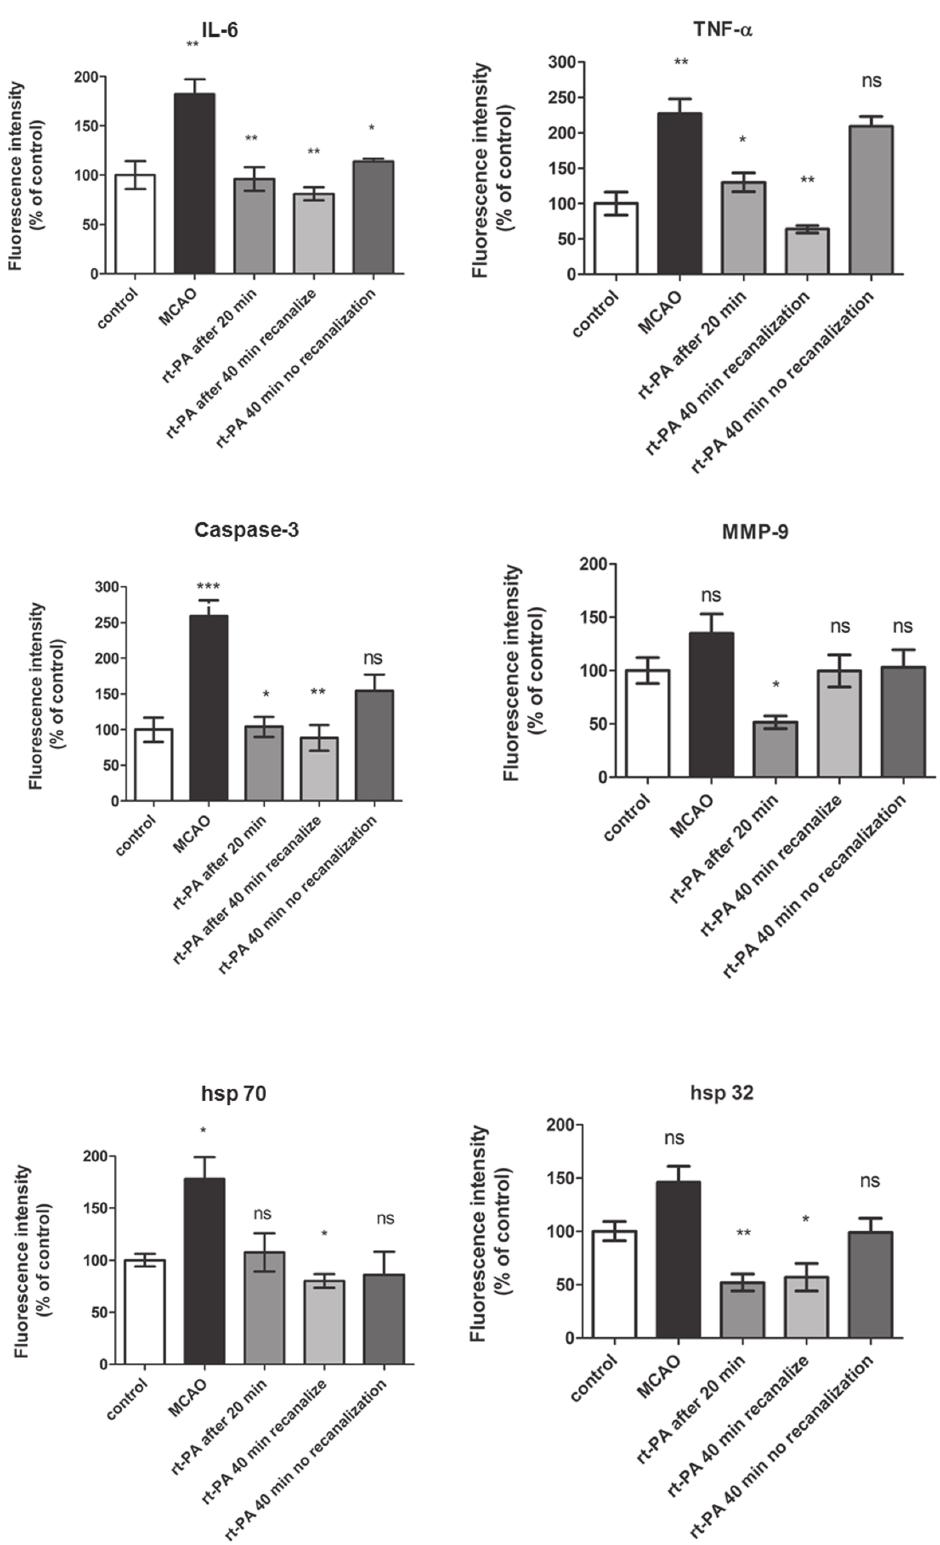
Figure 5. Bar graphs showing semi-quantification of fluorescence intensity for IL-6, TNF- a , Caspase 3, MMP-9, hsp 70 and hsp 32 proteins. Data are presented as the mean percentage relative to control 6 s.e.m.; n 5=9 *P # 0.05, significant difference between control groups and MCAO, # P # 0.05, significant difference between treated groups and MCAO groups. Statistical analyses were performed using Kruskal-Wallis non- parametric test together with Dunn’s post-hoc test.